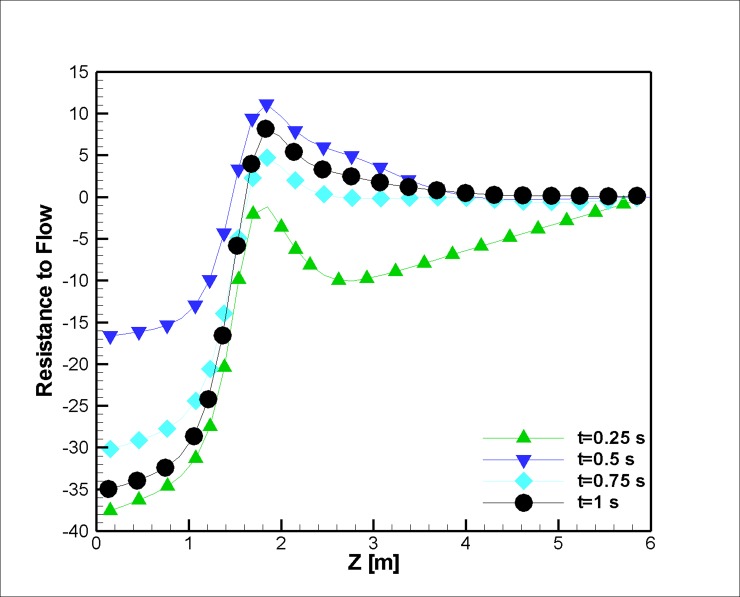
Variation in the resistance to the flow along the midline of the stenosis (r = 2.5 mm) for different time instances in the case with joule heating.(Lvessel
= 6 cm, Rvessel
= 1 cm, 50 percent stenosis).